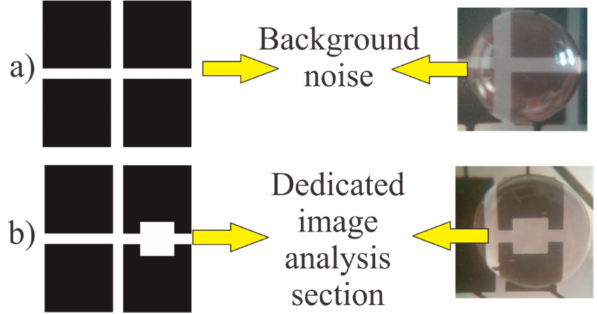
Figure 10. ( a ) Ordinary electrode design with background noise; ( b ) The new design with the dedicated image analysis